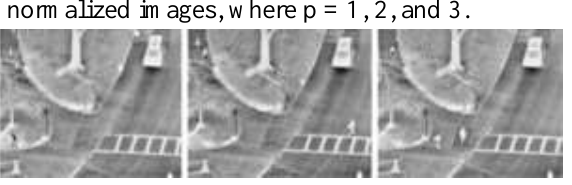
Figure 17. Subtracting main normalized images from matrix with same dimension with value of 1.